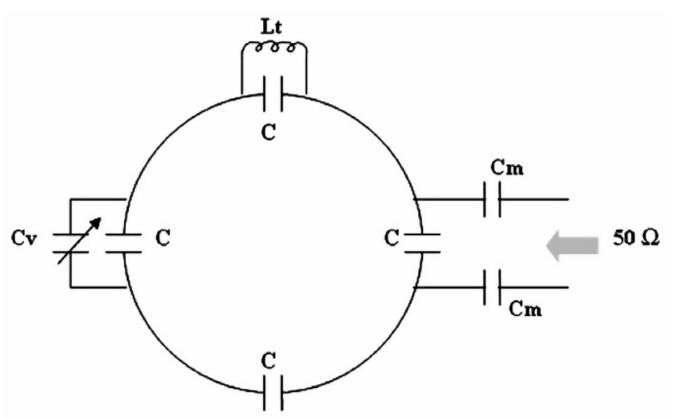
Figure 5. Sketch of the sodium surface coil. Reprinted by permission from Giovannetti et al., Measurement 2014